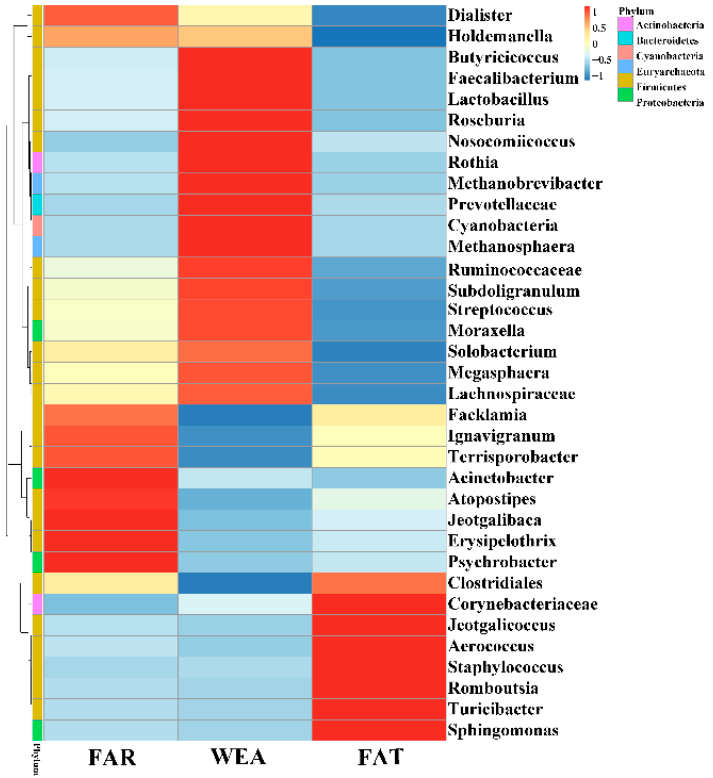
Figure 6. Heatmap of airborne bacterial relative abundance at the genus level. FAR, farrowing houses; WEA, weaning houses; FAT, fattening houses.